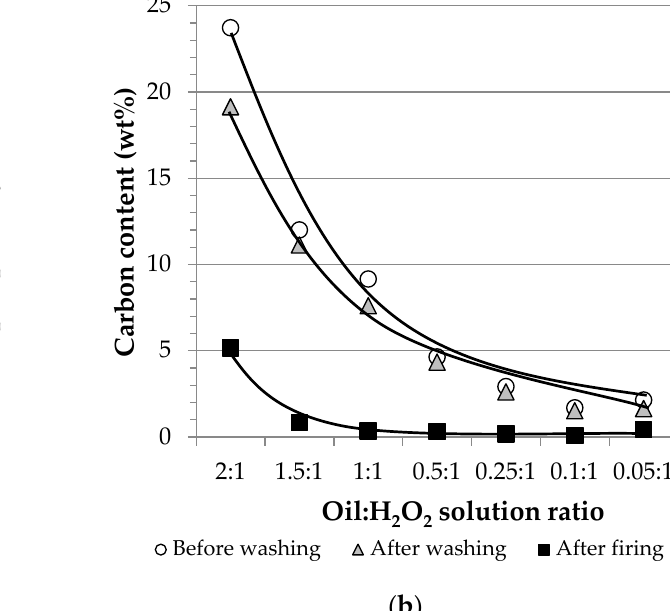
Figure 7. Effect of the oil content ( a ) on the compressive strength and open porosity, as well as ( b ) on the organic carbon content (Horizontal lines indicate boundary conditions in the case of the experimental job).